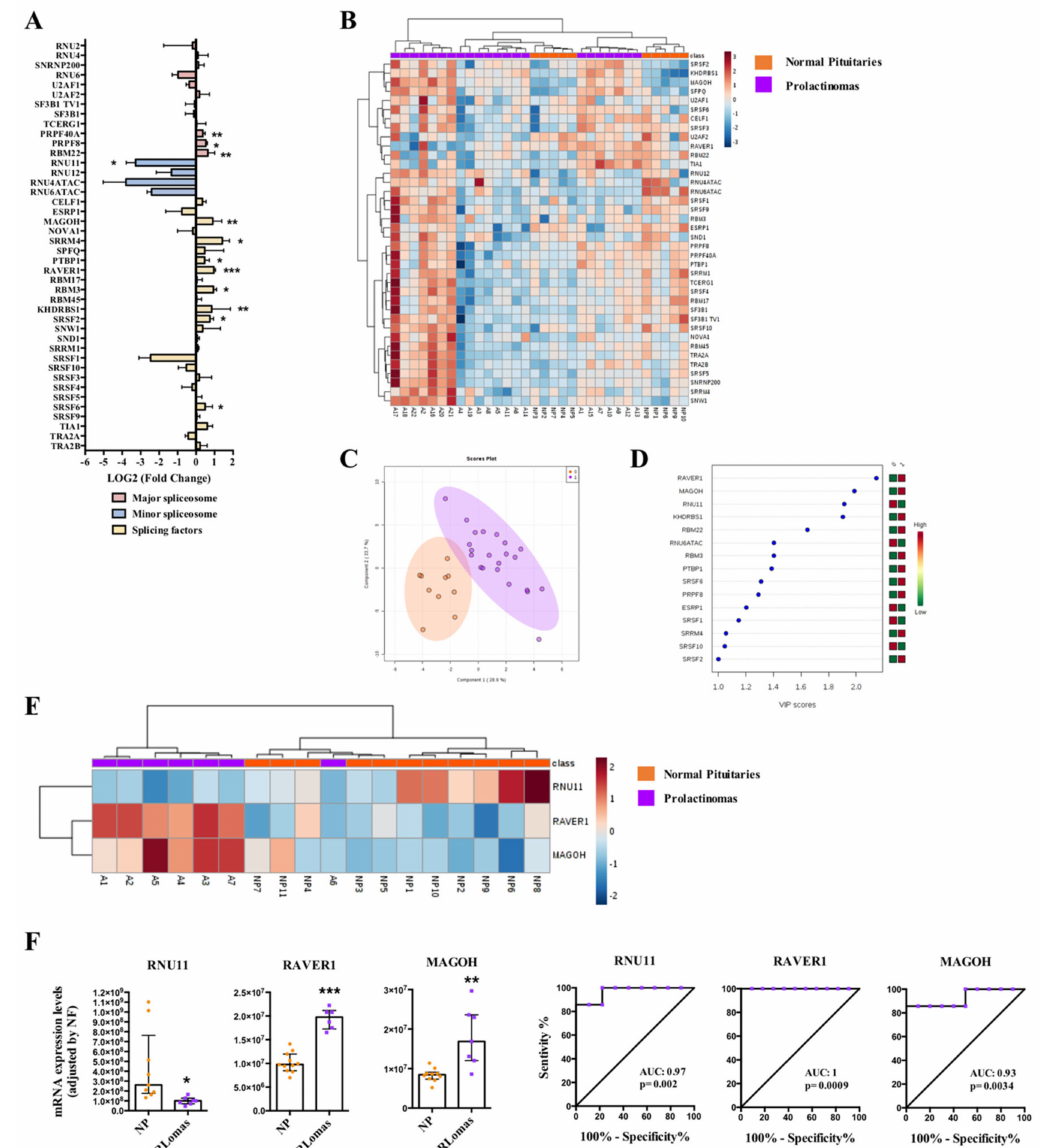
Figure 4. Prolactinomas (PRLomas). ( A ) Individual Fold-Change of each splicing-regulatory element expression levels in PRLomas compared to normal pituitary glands (NPs). ( B ) Heatmap of the mRNA expression levels of all splicing-regulatory elements measured in the qPCR array in PRLomas ( n = 7; green color) compared to NPs ( n = 11; red color). ( C ) Principal Components Analysis (PCA) of the mRNA expression levels of the splicing-regulatory elements analyzed in the same set of samples. ( D ) Variable Importance in Projection (VIP) Scores top-feature of Partial Least Squares Discriminant Analysis (PLS-DA). ( E ) Heatmap of the splicing-regulatory elements with higher VIP score in the same set of samples. ( F ) mRNA expression levels of splicing-regulatory elements with higher VIP score in PRLomas compared to NPs and Receiver Operating Characteristic (ROC) curves analyses showing the accuracy of the selected splicing-regulatory elements to discriminate between PRLomas and NPs. Data represent median ± interquartile range of absolute expression levels (copy number) of each transcript adjusted by a normalization factor. Asterisks (* p < 0.05; ** p < 0.01, *** p < 0.001) indicate statistically significant di ff erences between